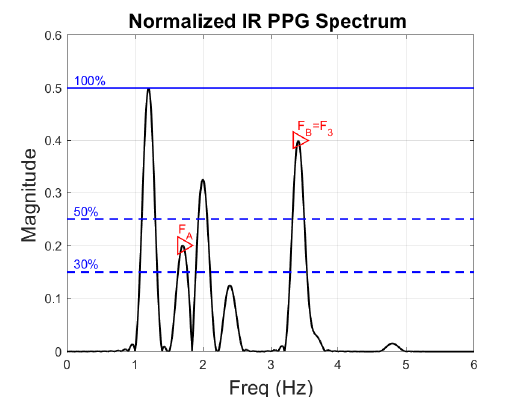
Figure 6. Illustration of the frequency spectrum of a typical IR PPG signal. The red triangles correspond to the pair of frequencies, F A and F B , that has a harmonic relationship. Frequency F B is the same as frequency F 3 from Figure